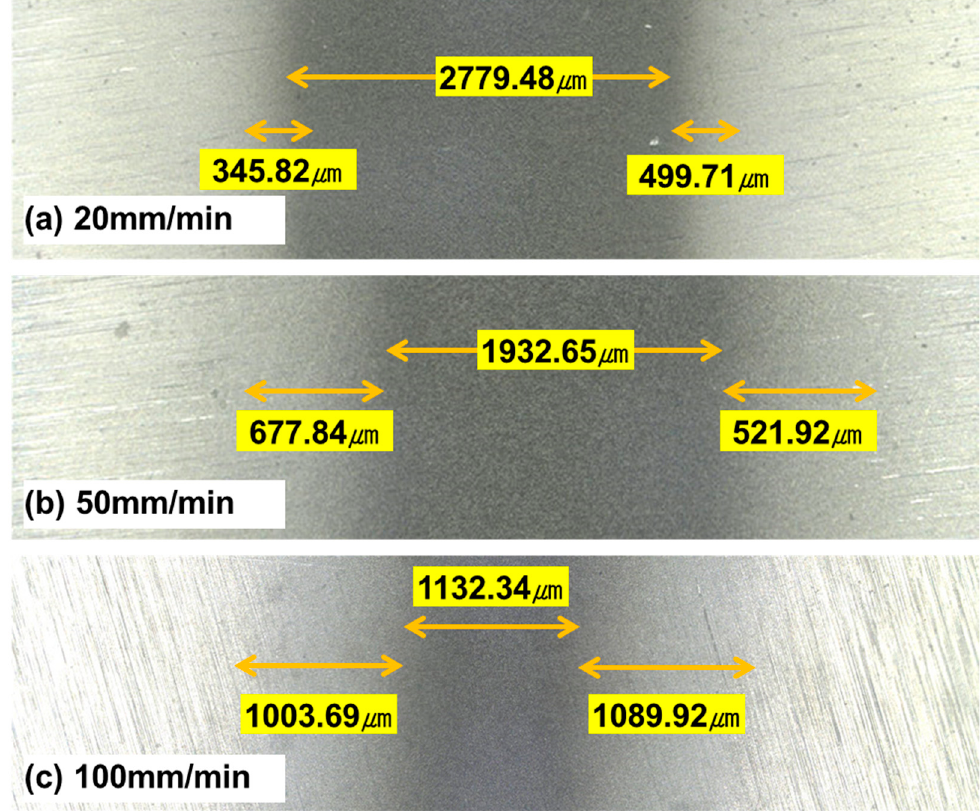
Figure 7. Optical microscopic images of surface textures machined by the micro-AAJ machining system at di ff erent traverse speeds. system at different traverse speeds.